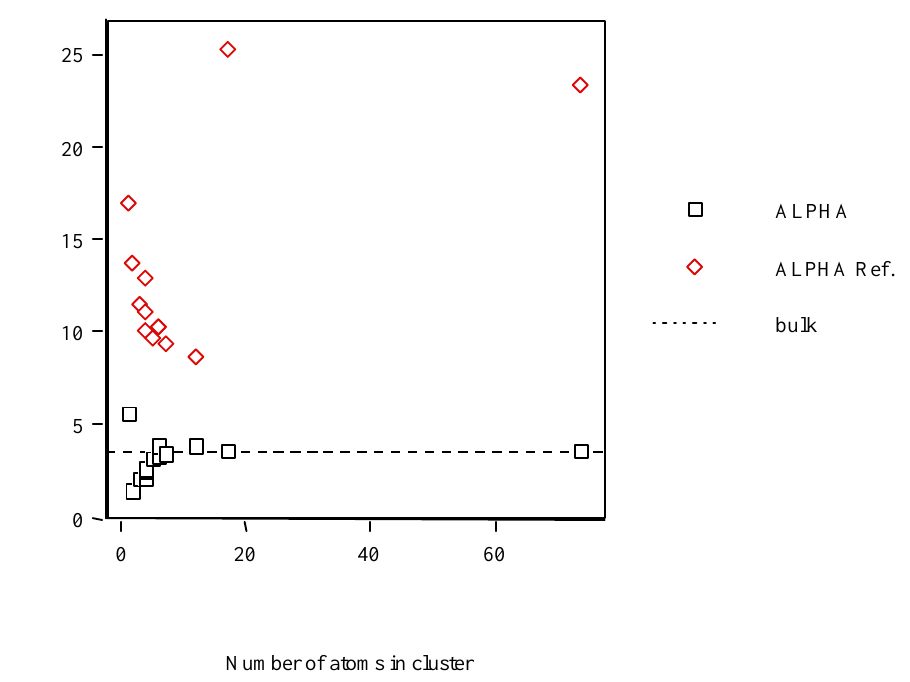
Figure 1. Average atom-atom polarizabilities per atom of Sc Dotted lines correspond to the bulk